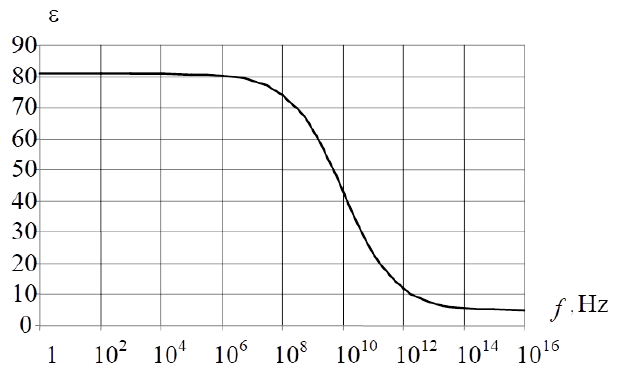
Fig. 2. Frequency dependence of the dielectric constant of water. For the calculation of the frequencies of the inner part of the ellipsoid, the semi-axes of the ellipse ( ba , ) are introduced, with 22 2/ abd  . Figure 3 shows the dependence of the H and E oscillation frequencies on the form of the resonator ( b = 10 µm). Similar 101 101 results were obtained in [9].